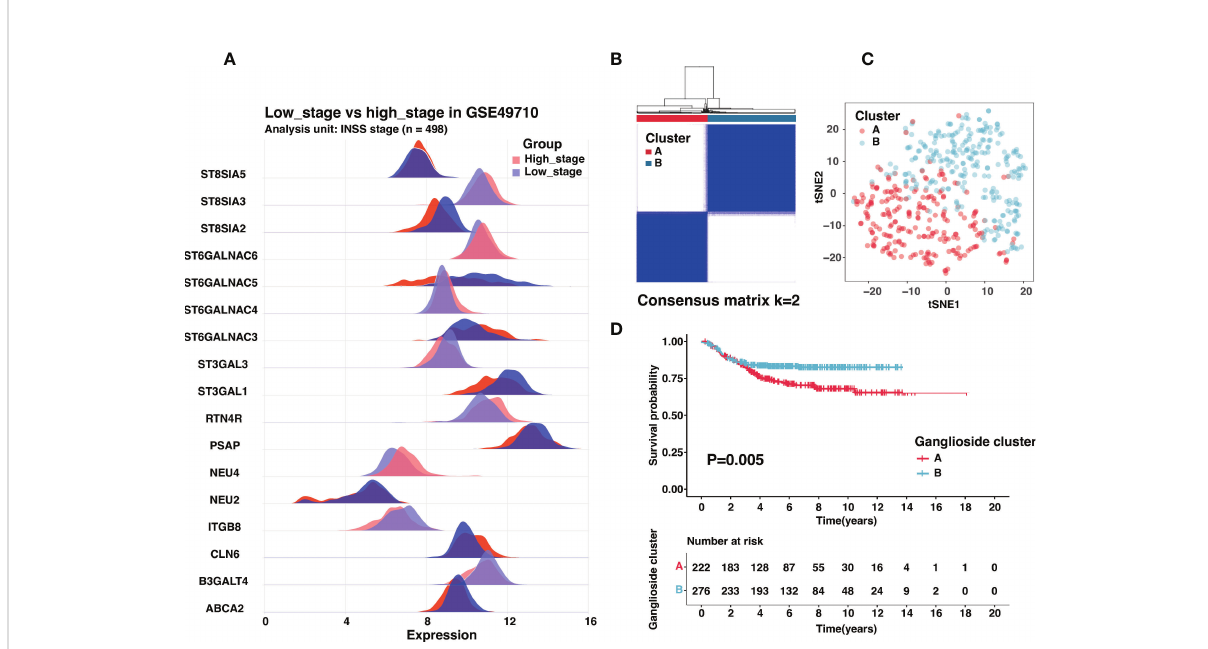
FIGURE 1 Identi fi cation of ganglioside-related clusters in the GSE49710 dataset. (A) The expression of ganglioside-related genes that were differentially expressed between samples with high stage (INSS stage 4) and low stage (other stages). (B) Identi fi cation of two ganglioside-related clusters according to the consensus clustering matrix (k = 2) in the GSE49710 cohort. (C) The t-SNE analysis revealed a clear distinction between the two clusters. (D) Kaplan – Meier curves of overall survival (OS) in the GSE49710 cohort between different